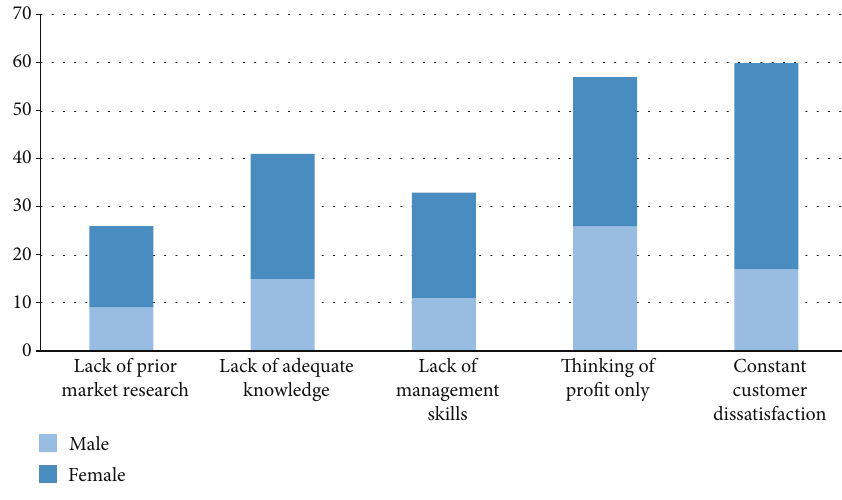
Figure 8: Failure in